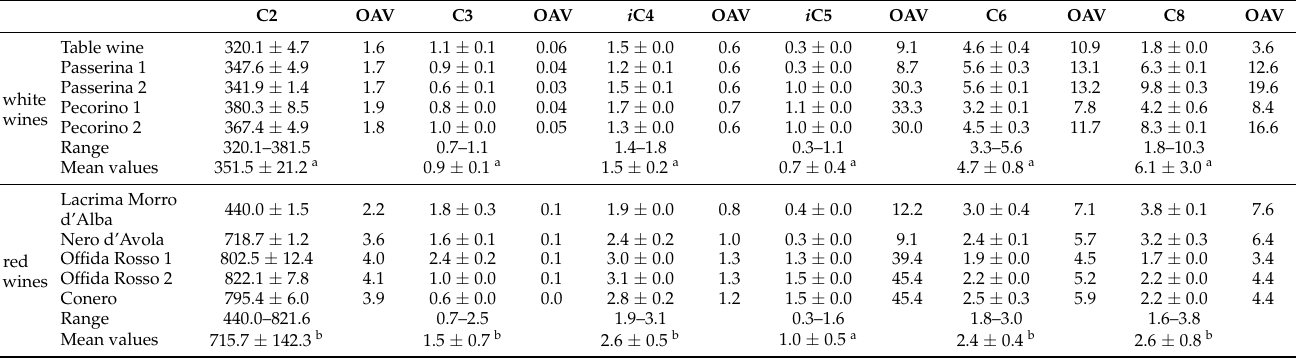
Table 4. Mean concentrations (mg L − 1 ) ± standard deviations ( n = 2) of SCFAs and MCFAs in wine samples, ranges of concentrations, mean values in red and white wines and calculated odor active values